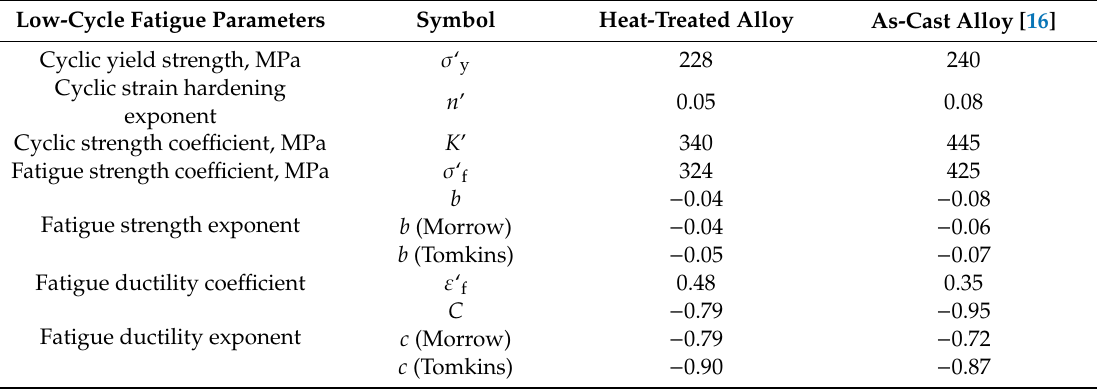
Table 2. Low-cycle fatigue (LCF) parameters of the alloy in the heat-treated and as-cast